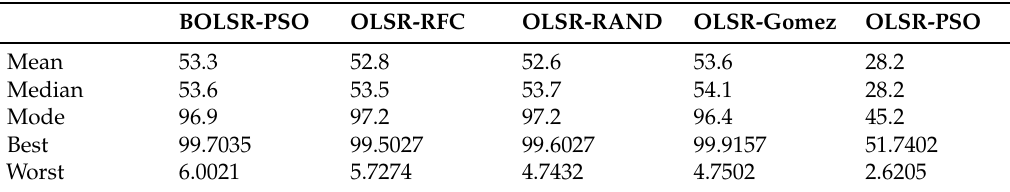
Table 6. Statistical Result of PDR Performance